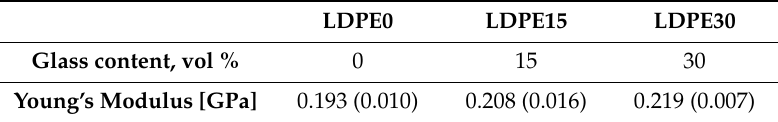
Table 1. Young’s modulus of the